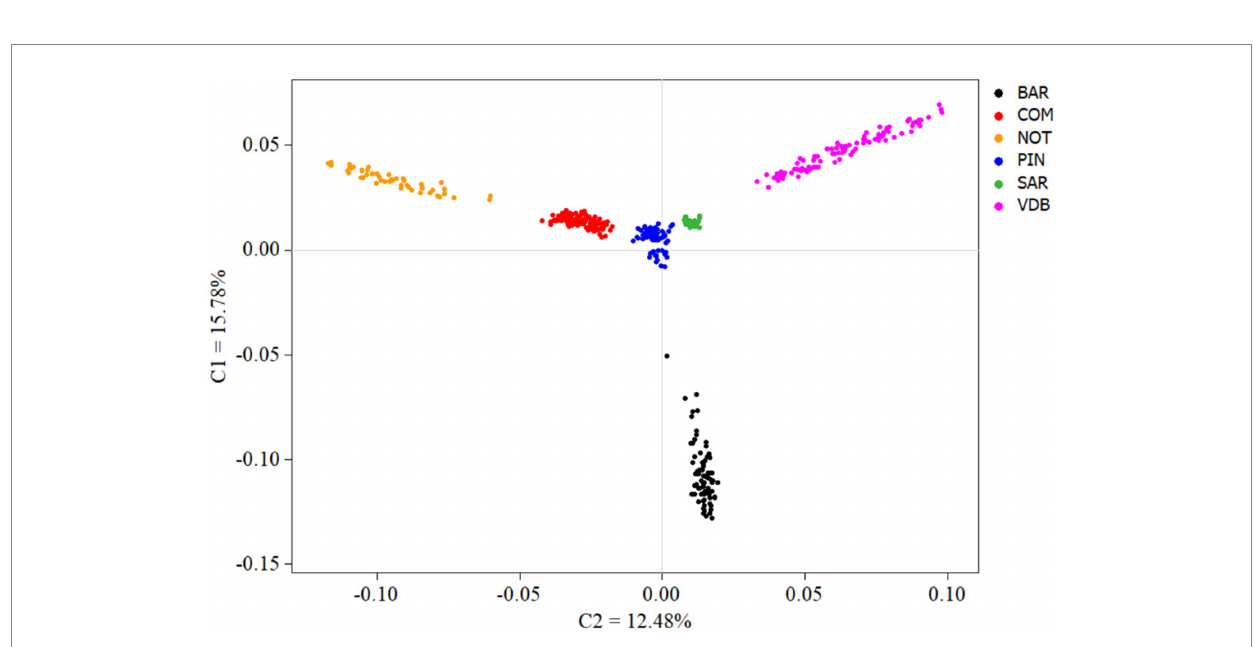
FIGURE 4 Multidimensional scaling analysis of SICPOP dataset, comprehensive of 6 breeds in total. For full definition of the breeds, see Table